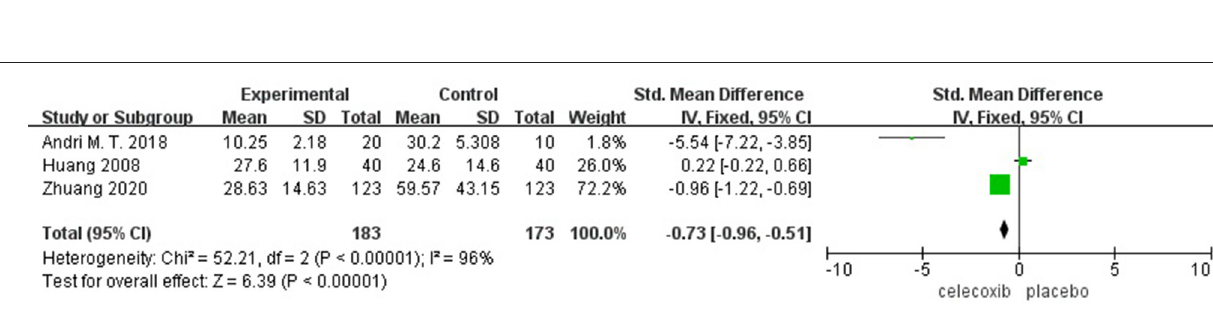
FIGURE 3 | Forest plot for the meta-analysis of VAS scores at rest at postoperative (A) 24h, (B) 48h, and (C) 72h.